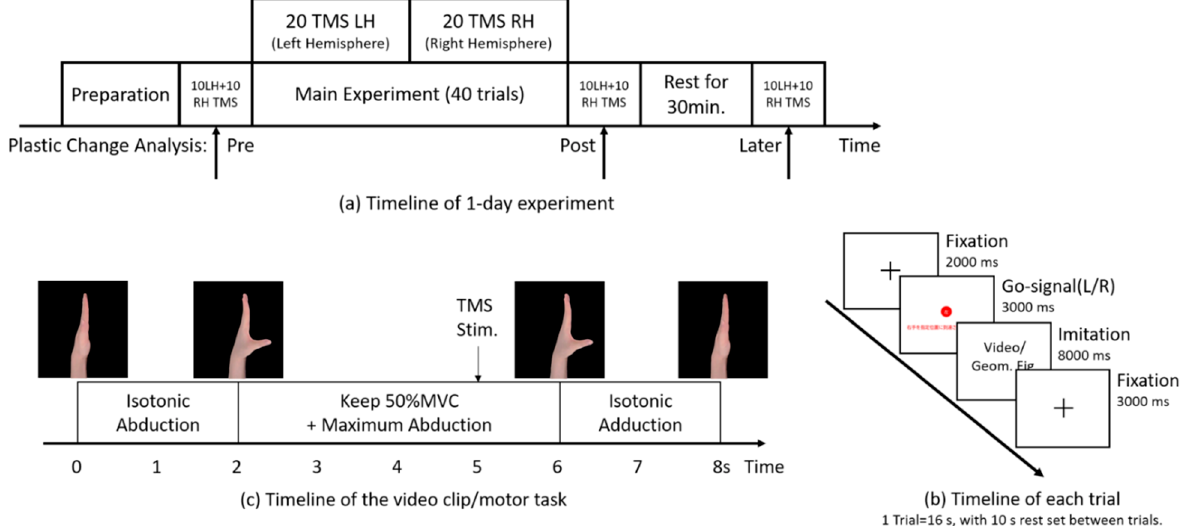
Figure 1. Timeline for the experimental conditions. (a) Timeline of 1-day experiment. The main experiment consisted of 40 trials of imitation. Single-pulse transcranial magnetic stimulation (TMS) was delivered to either hemisphere (LH = left hemisphere; RH = right hemisphere) during imitation in each trial. TMS-evoked ipsilateral silent period (iSP) was recorded from the abductor pollicis brevis (APB) ipsilateral to the TMS pulse. Plasticity change was assessed by 60 iSP measurements set immediately before the main experiment (pre), immediately after the main experiment (post) and 30 min rest after the main experiment (later), with 10 iSPs from each hand, measured at each time point. (b) Timeline of each trial (16 s). Then, a 10 s rest interval was set between trials. (c) Timeline of the 8 s video clip. The video consisted of 2 s isotonic thumb abduction, 4 s retention at the maximum abduction position with 50% MVC and isotonic thumb adduction for 2 s. Focal TMS pulse over M1 was delivered at the 5 s time point of the video clip. The pace of each trial was controlled by a 1 Hz metronome synchronized with the 16 s trial.